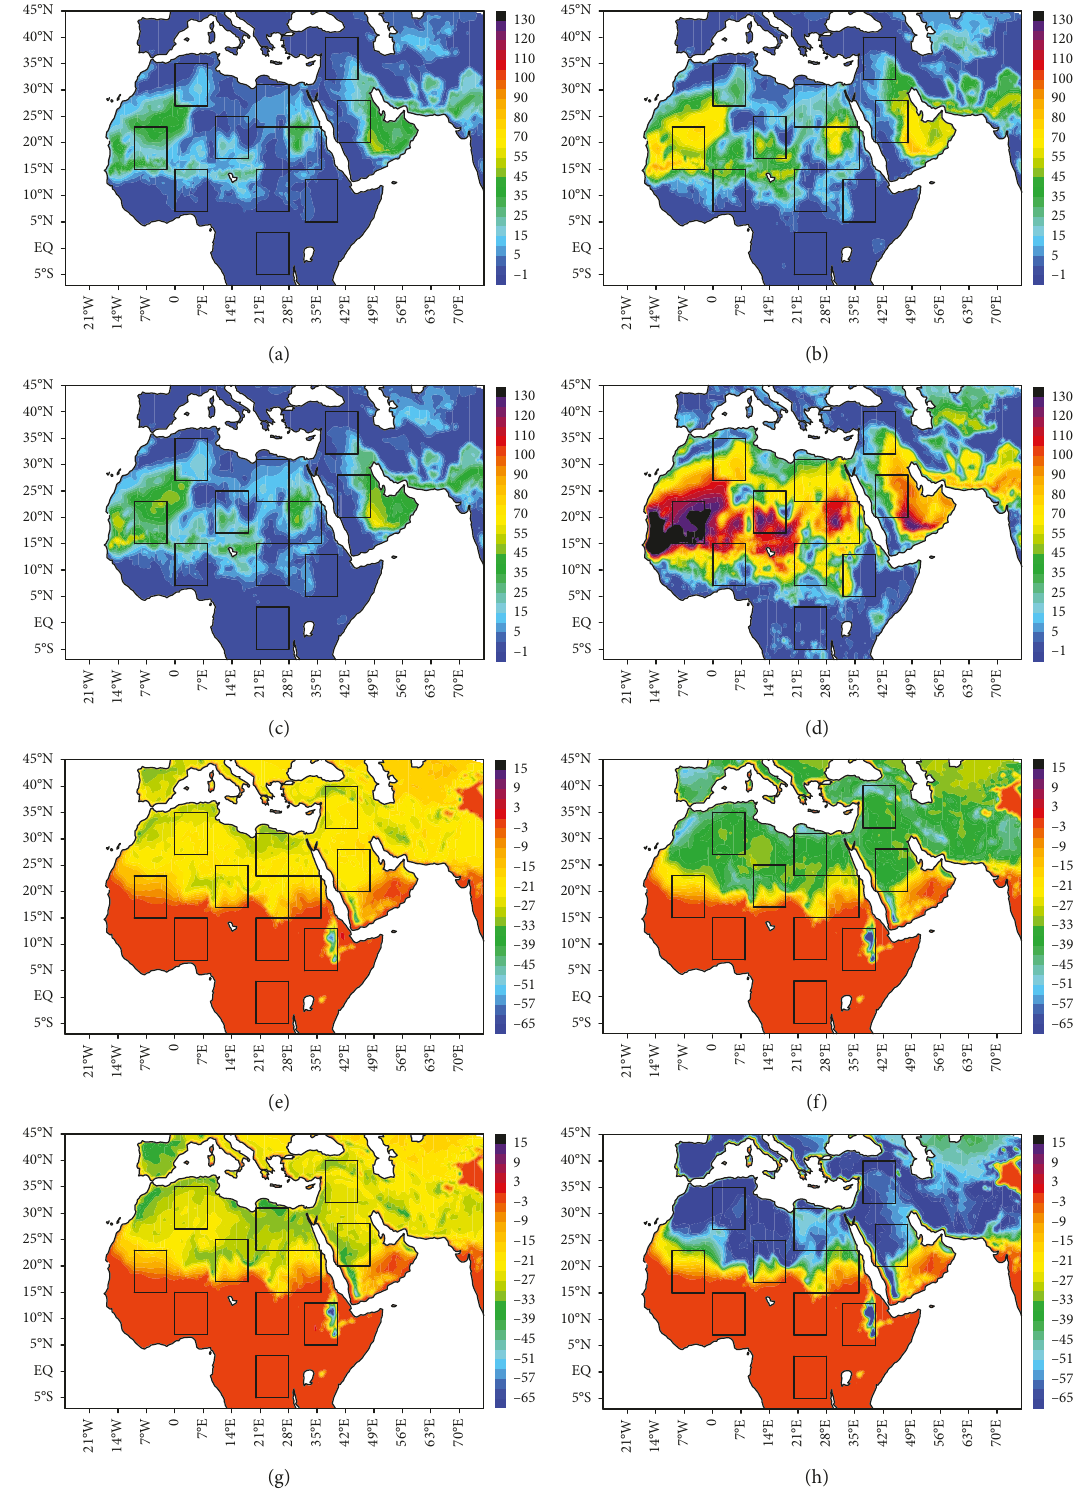
Figure 10: Spatial distribution of changes in hot days ( T ° C) for (a) RCP4.5 near future, (b) RCP4.5 far future, (c) RCP8.5 near future, max > 50 and (d) RCP8.5 far future along with cold nights ( T min < 5 ° C) for (e) RCP4.5 near future, (f) RCP4.5 far future, (g) RCP8.5 near future, and (h) RCP8.5 far future with respect to the base period (1971–2000). Average is taken over HadGEM2- and ECHAM6-driven